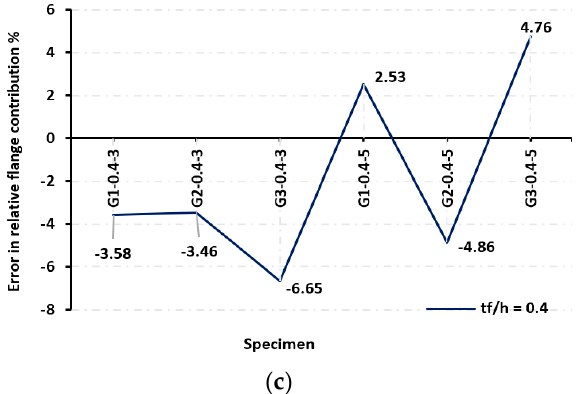
Figure 13. Error in relative flange contribution between all tested specimens with and without web stirrups by FE model. They should be listed as: ( a ) specimens with t f /h = 0.3; ( b ) specimens with t f /h = 0.4; ( c ) specimens with t f /h = 0.5.